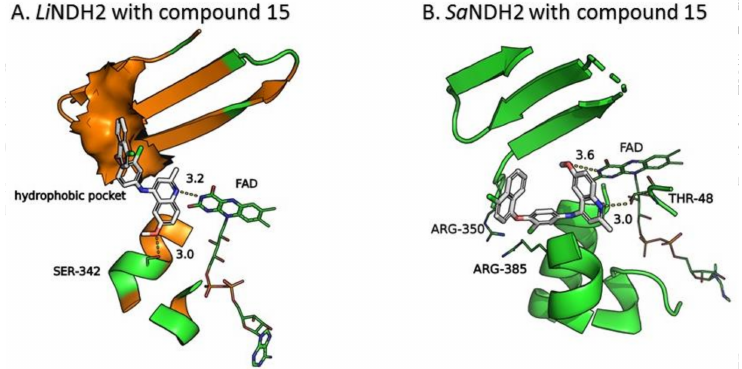
Figure 5. Proposed binding modes of the substituted 6-methoxy-quinalidine compound 15 at ( A ) Li NDH2 UQ I binding site; and ( B ) Sa NDH2 UQ binding